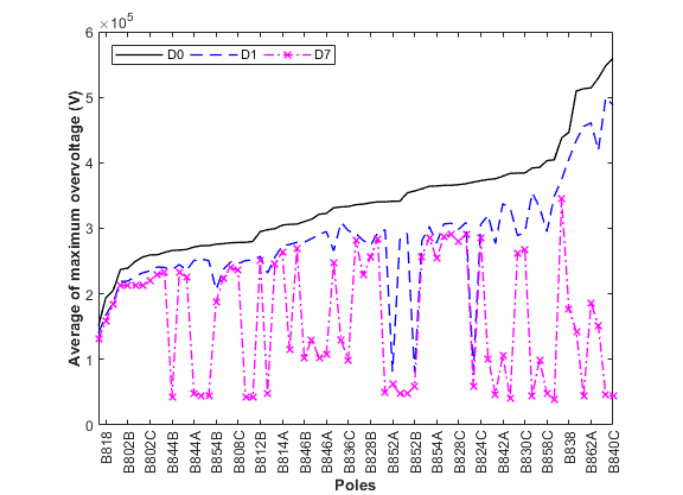
Figure 26. Average values of maximum overvoltages for m = 0.25 and n = 0.75: without lightning arresters (D0); lightning arresters at the transformer’s pole only (D1); and lightning arresters at the transformer’s pole and at the six most critical poles